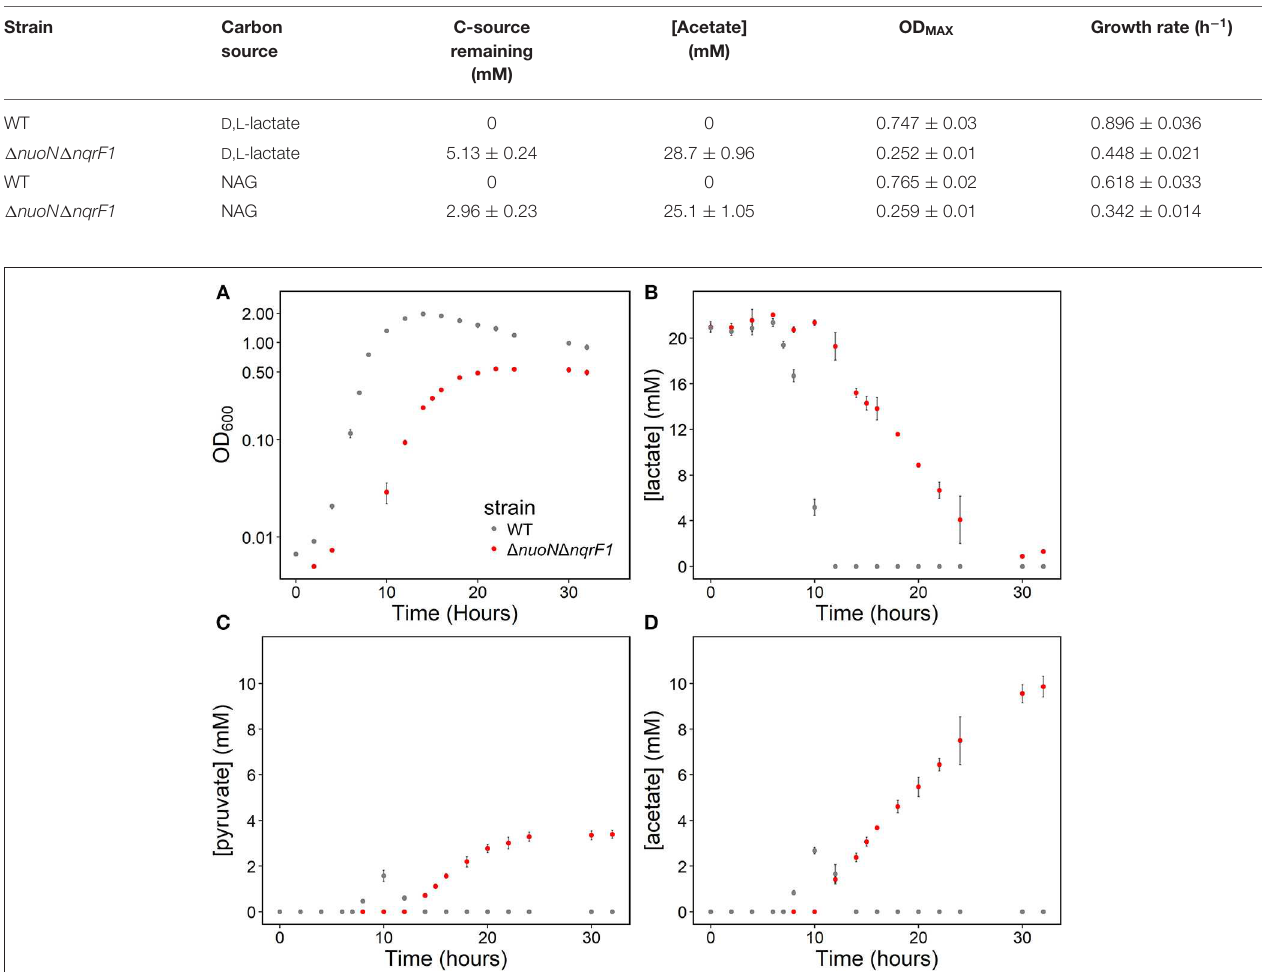
FIGURE 3 | (A) Growth of WT (gray) and 1 nuoN 1 nqrF1 (red) in 50-mL culture volumes of M5 minimal medium supplemented with 0.1% tryptone and 20mM D,L -lactate. (B) D,L -lactate utilization by WT and 1 nuoN 1 nqrF1 . (C) Pyruvate and (D) acetate concentrations in culture